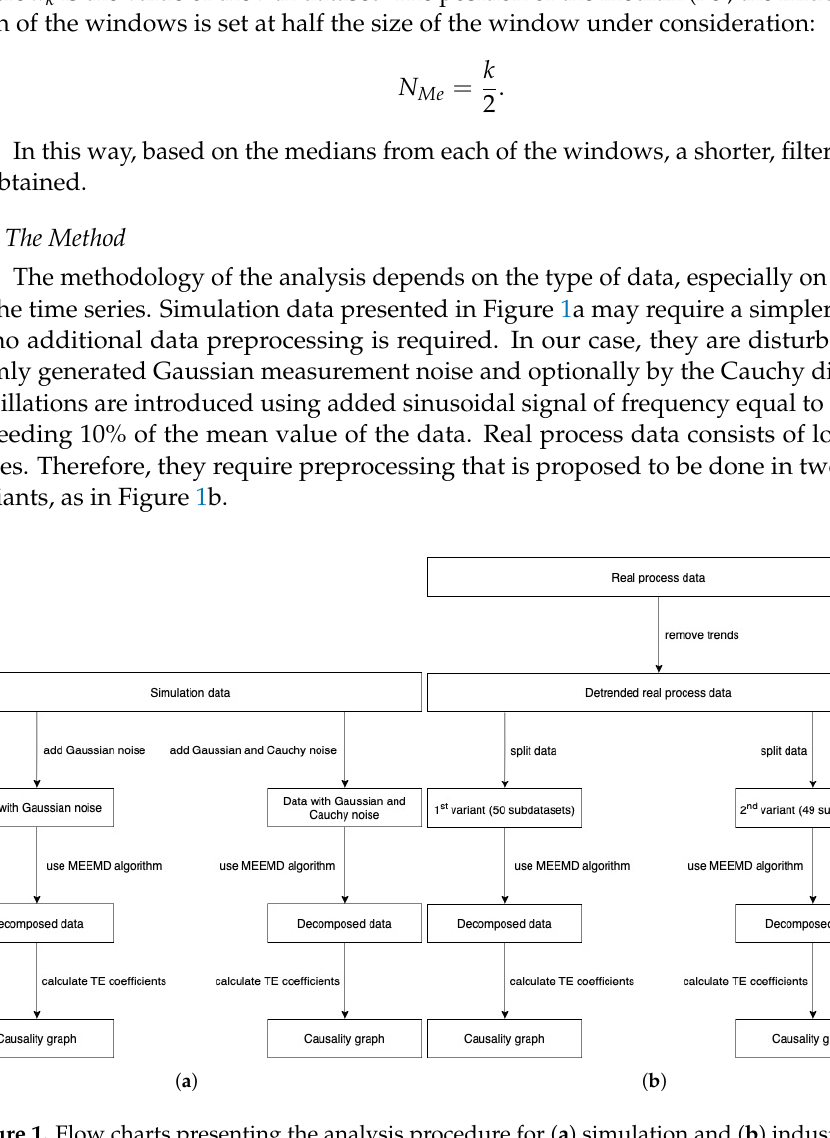
Figure 1. Flow charts presenting the analysis procedure for ( a ) simulation and ( b ) industrial